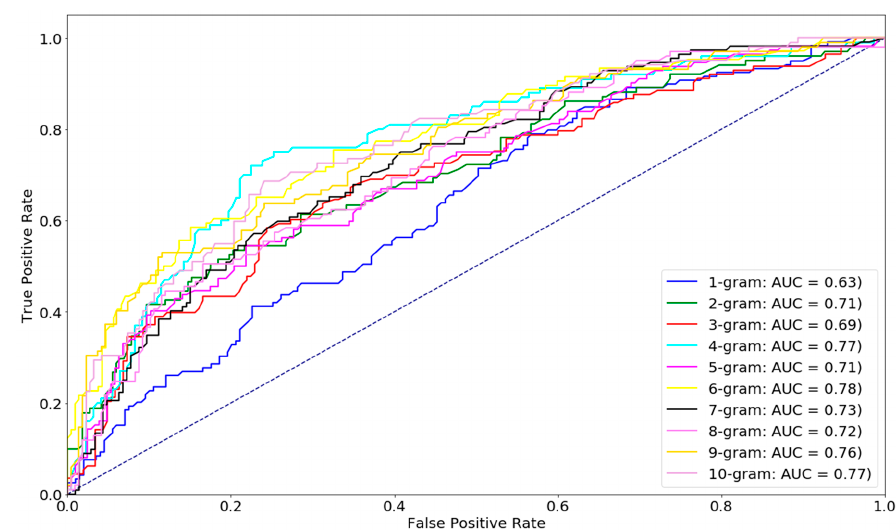
Figure 1. Identification of essential genes at different levels of fastText n-grams. The performance of 6-g (area under the receiver operating characteristic curve (AUC) = 0.78) was better than the other levels. Table 1. Hyperparameters of di ff erent machine learning and deep learning classifiers used in this study. KNN: k-nearest neighbors; RF: random forest; SVM: support vector machine; MLP: multi-layer perceptron; and CNN: convolutional neural